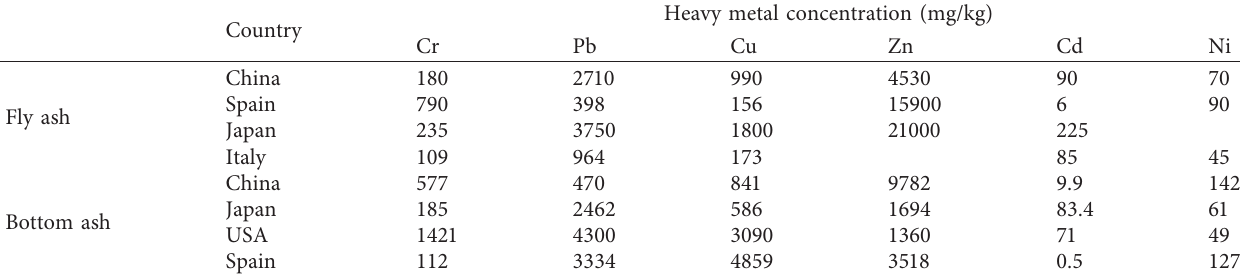
Table 2: Heavy metals in MSWI fly ash and bottom ash.